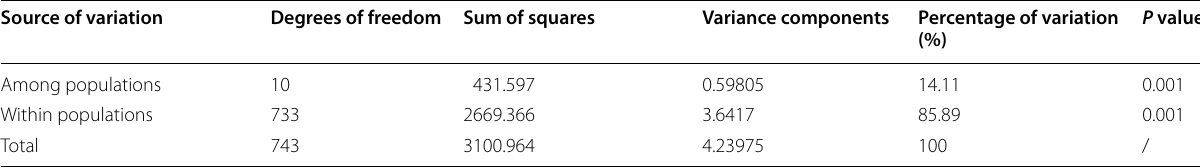
Table 4 Analysis of molecular variance (AMOVA) within and among populations of Puccinia triticina Source of variation